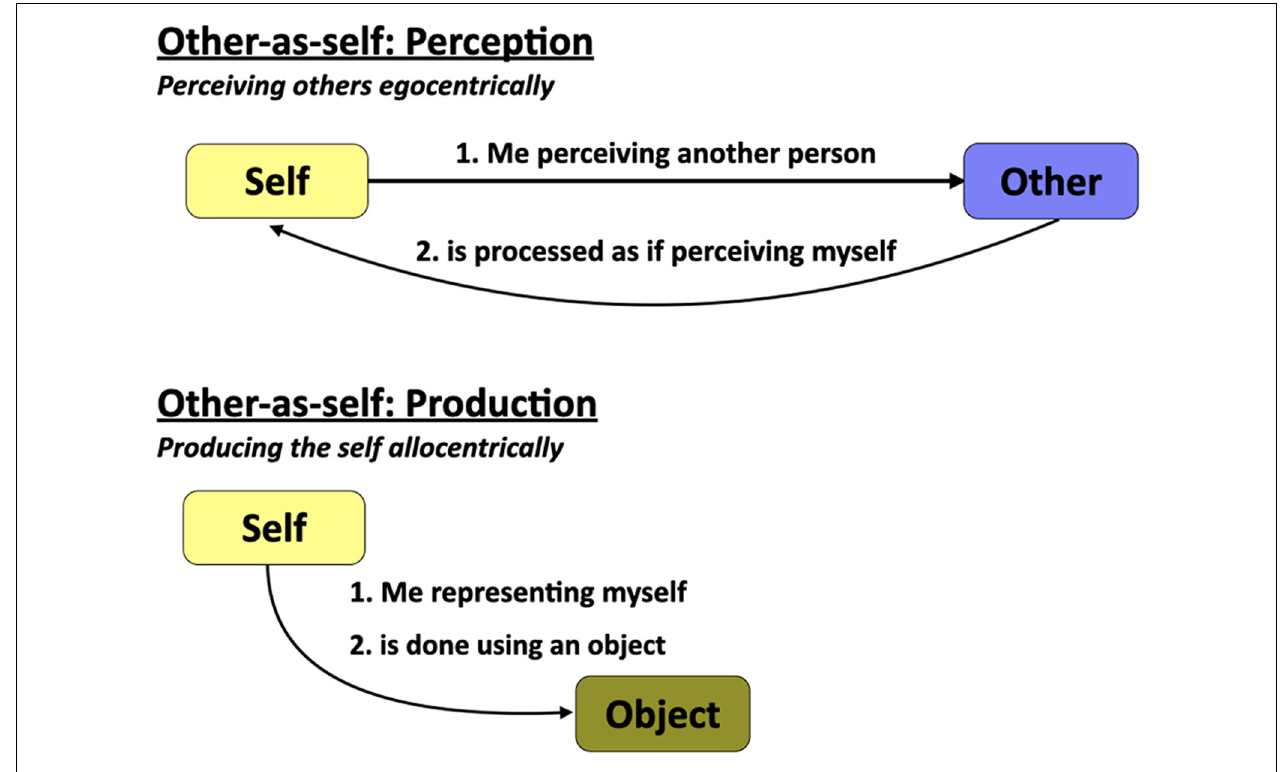
FIGURE 2 | The other-as-self mechanism. The principal other-as-self mechanism is found in perception (top panel): perceiving others egocentrically through mentalizing processes. A second, though uncommon, mechanism is found in production (bottom panel): producing the self allocentrically. This can occur as a projection of the self onto a self-avatar or other object, for example in virtual reality applications. The term “object” is used here to refer to either a physical or virtual representation of the